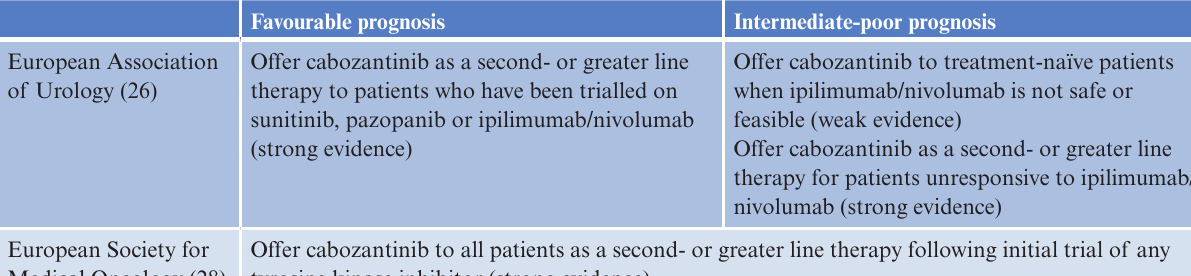
Table 2. Clinical guidelines outlining the role of cabozantinib in the management of metastatic clear cell renal cell carcinoma Favourable prognosis Intermediate-poor